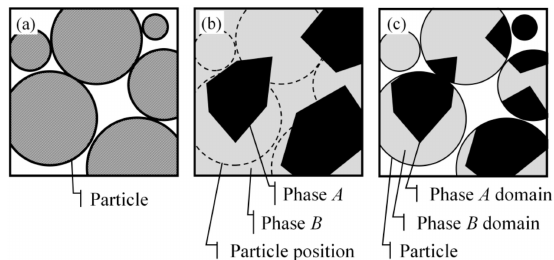
Figure 2. Binary particle modeling procedure: ( a ) generation and packing of spherical particles; ( b ) phase A and B structure generation; ( c ) particle hollowing based on the binary structure (based on a previous study